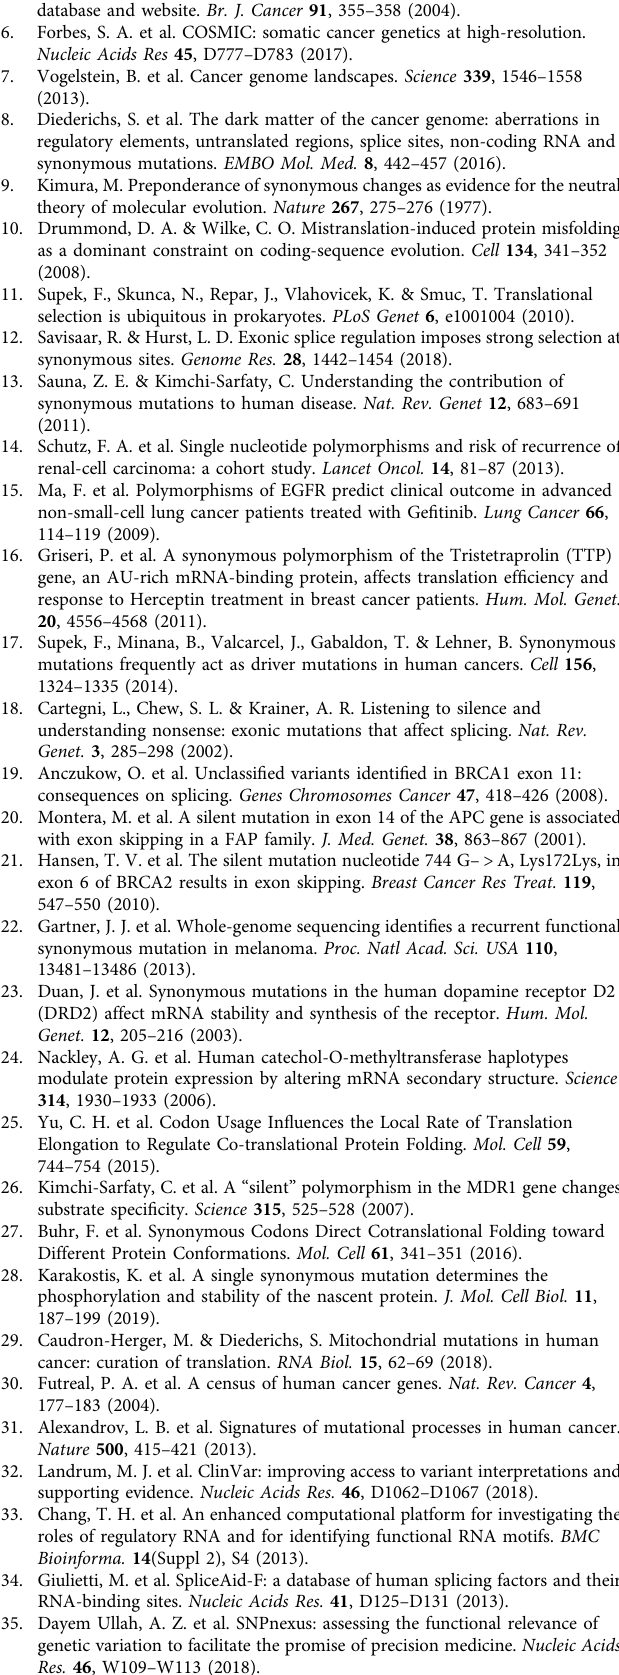
Supplementary Fig. 8a, 8c and 8d are provided as a Source Data File. The replicates for Fig. 6d are provided in Supplementary Fig. 7. The SynMICdb can be found at http://